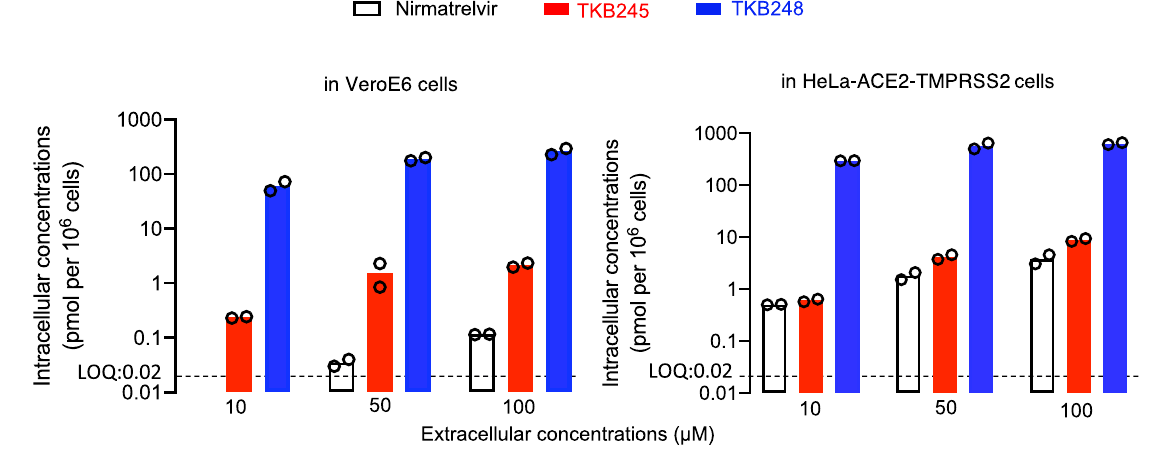
Fig. 1 | Intracellular concentrations of TKB245 and TKB248. VeroE6 or HeLa- ACE2-TMPRSS2cellswereincubatedwith10,50,and100 μ Mofeachcompoundfor 6hours, vigorously washed with PBS, and intracellular concentrations of each